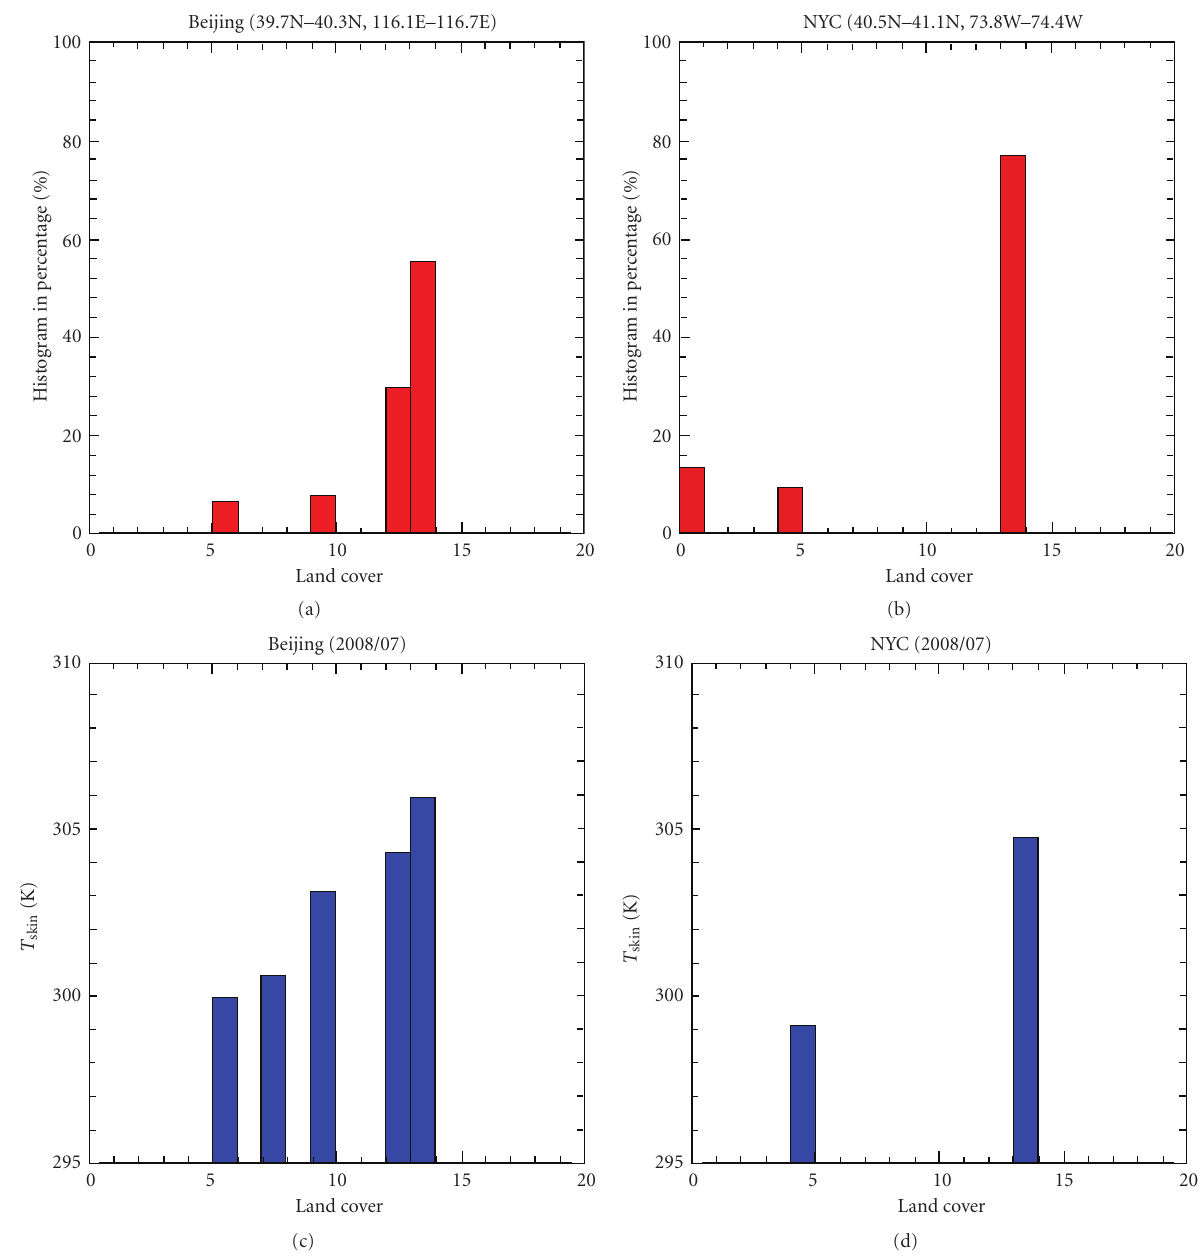
Figure 2: Land-cover averaged skin temperature for Beijing and New York City. (a) and (b) are land cover percentages for 0 . 6 × 0 . 6 box for Beijing (39.7 ◦ –40.3 ◦ N, 116.1 ◦ –116.7 ◦ E) and New York City (40.5 ◦ –41.1 ◦ N, 78.3 ◦ –74.4 ◦ W). Land cover type is defined in MODIS as (1) evergreen needleleaf forest, (2) evergreen broadleaf forest, (3) deciduous needleleaf forest, (4) deciduous broadleaf forest, (5) mixed forest, (6) closed shrubland, (7) open shrubland, (8) woody savannas, (9) savannas, (10) grassland, (11) permanent wetland, (12) croplands, (13) urban and built-up, (14) cropland/natural vegetation mosaic, (15) snow and ice, (16) barren or sparsely vegetated. (c) and (d) are skin temperature versus land cover in the 0 . 6 ◦ × 0 . 6 ◦ boxes for beijing and new york city, respectively.